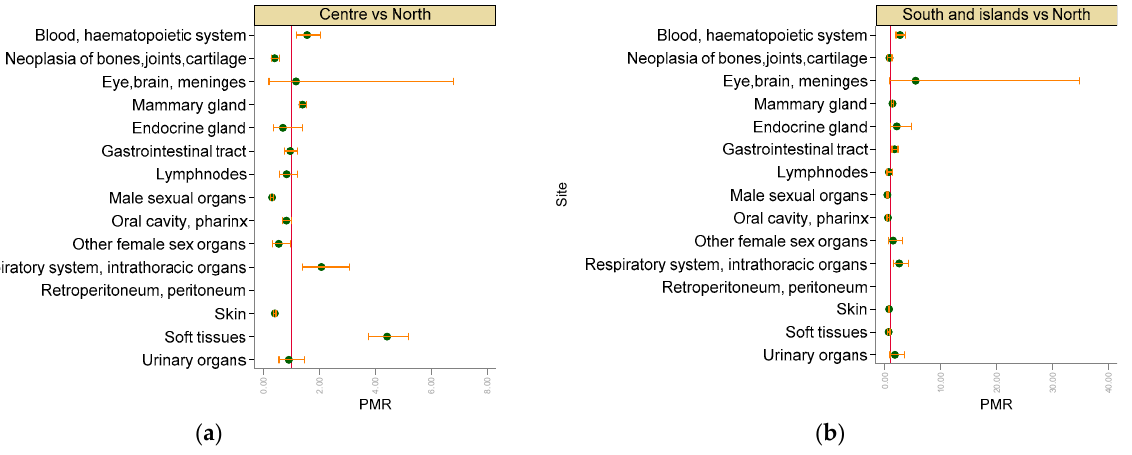
Figure 8. Proportional morbidity ratios (PMR) of malignant tumours by topography comparing the Italian macro regions (North, Centre, South and islands) with the others. Dots: age-clas- adjusted PMRs, bars: lower and upper bound of 95% confidence interval. A vertical reference line indicates PMR = 1.